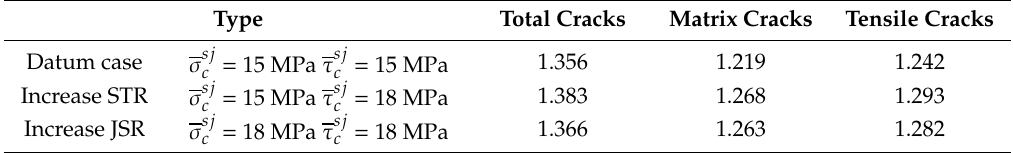
Table 3. Average of fractal dimension for di ff erent micro-cracking morphology in three